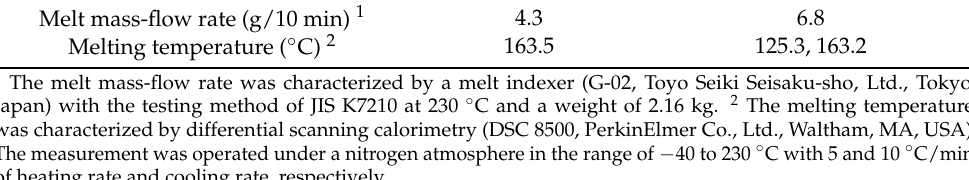
Figure 1. Photo images of the sample used in this study ( a ) VPP; ( b ) RPP-original; and ( c ) RPP- extrusion. Table 1. The melt mass-flow rate and melting temperature of VPP and RPP-original used in this study.